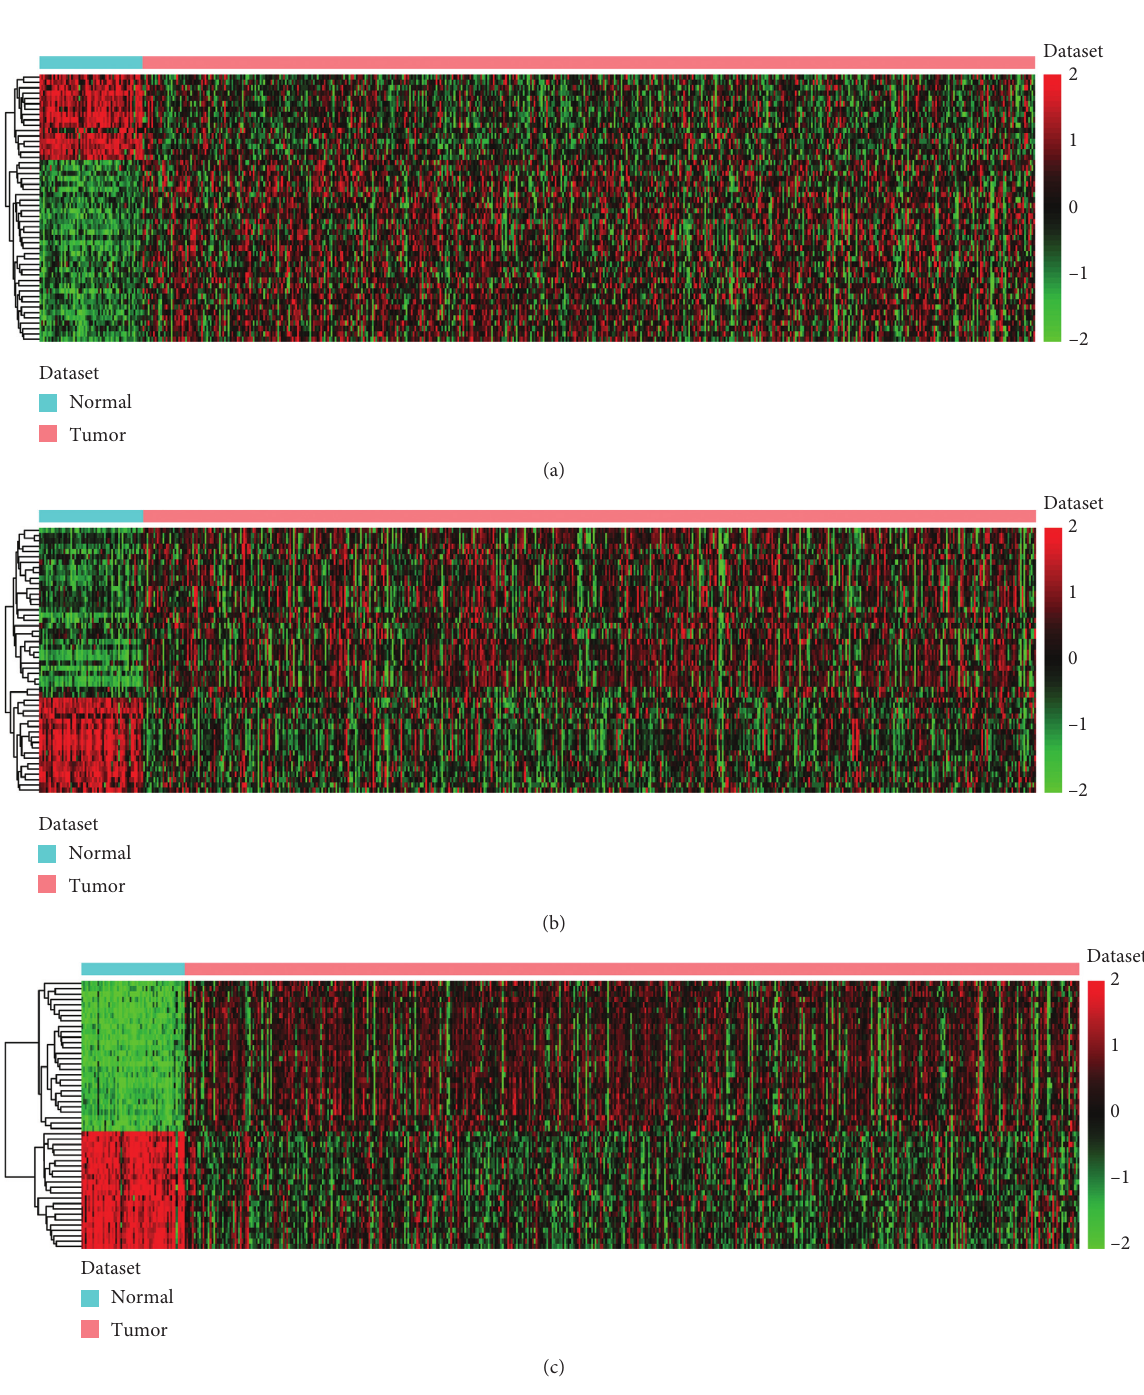
Figure 1: The heat maps of top 50 lncRNAs (a), top 50 miRNAs (b), and top 50 mRNAs (c) in PTC downloaded from the TCGA dataset. The diagram presents the result of a two-way hierarchical clustering of top 50 lncRNAs/miRNAs/mRNAs and samples. The differentially expressed lncRNA/miRNA/mRNA clustering tree is shown on the